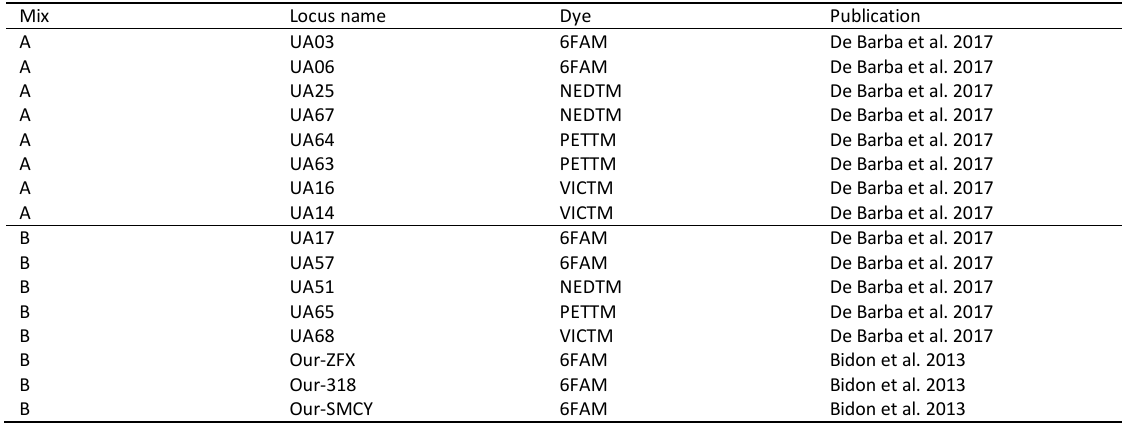
Table S3: Combination of microsatellite markers used in each PCR mix and type of fluorescent dye used for each microsatellite marker from 2017 to